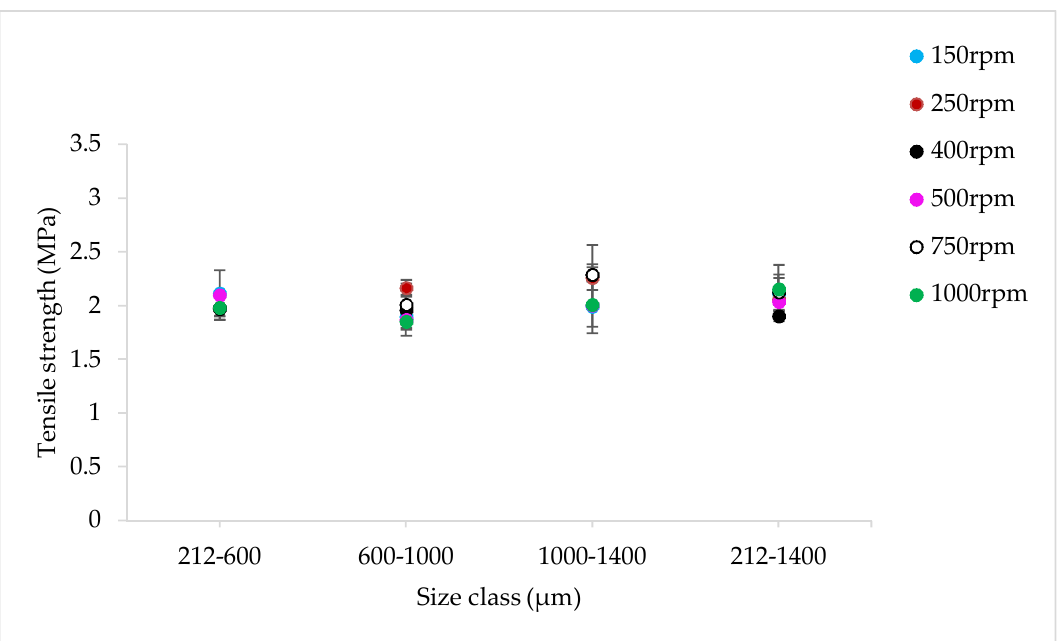
Figure 23. Tensile strength of tablets of MCC granules produced at varying screw speed at SFL—0.166 and PFN—1.34837 × 10 −4 (L/S 1).